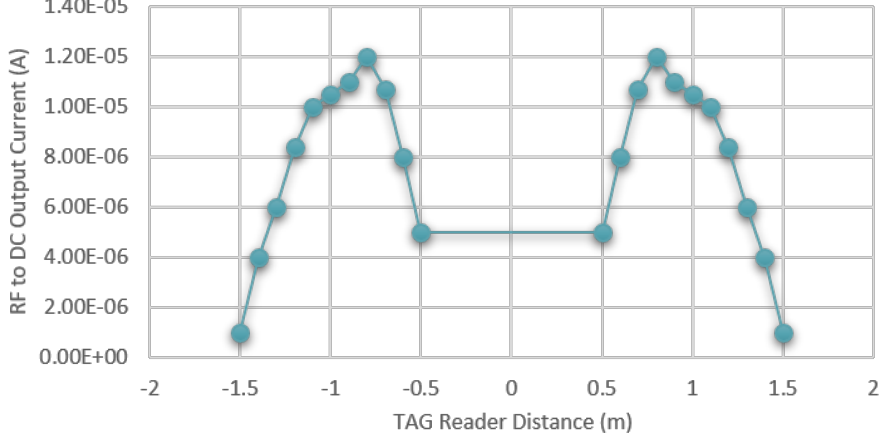
Figure 8. RF to DC output current vs. distance between tag and reader @ 868